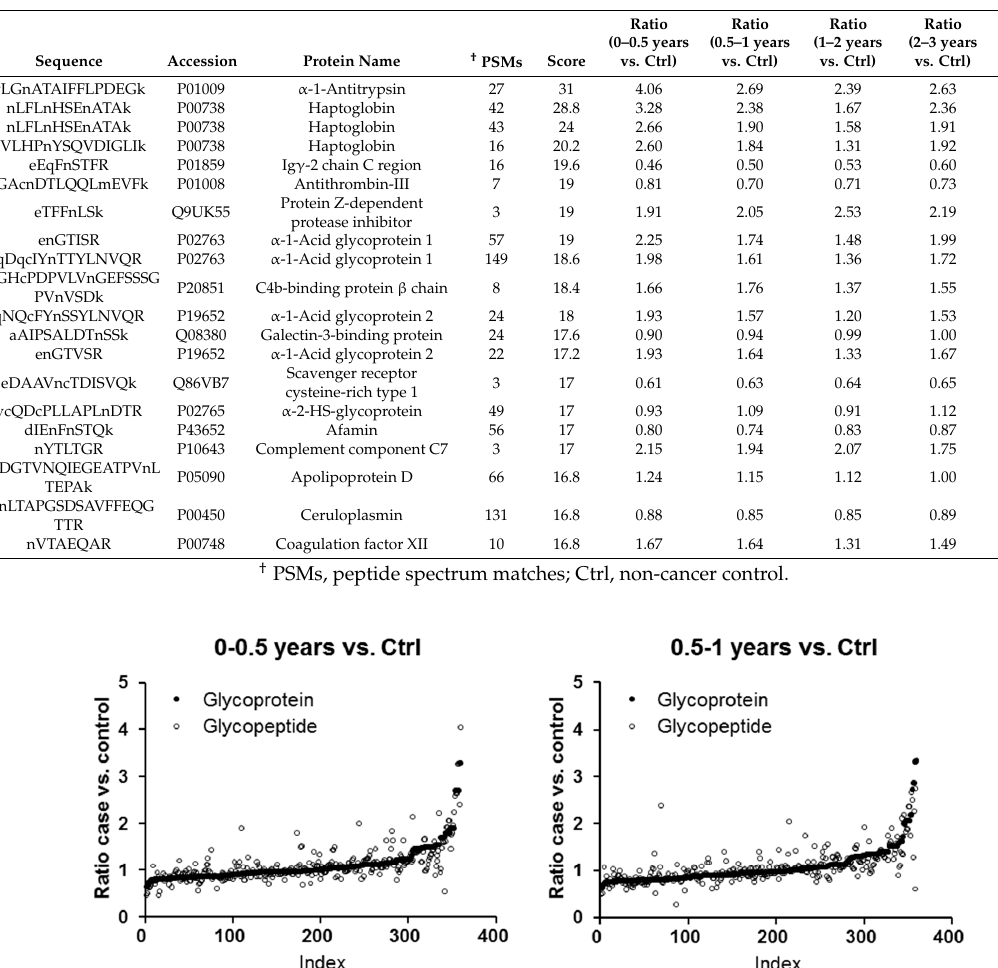
Table 2. Top-scoring glycopeptides. The 20 highest-scoring glycopeptides are shown with number of peptide spectrum matches, score, and ratios of expression in cases versus controls for each time group.